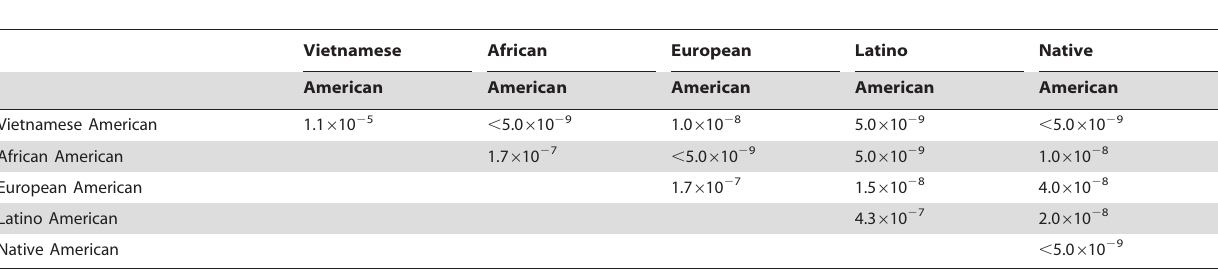
Table 2. False positive sibling identification rates between pairs of unrelated individuals simulated from all pairs of population samples.